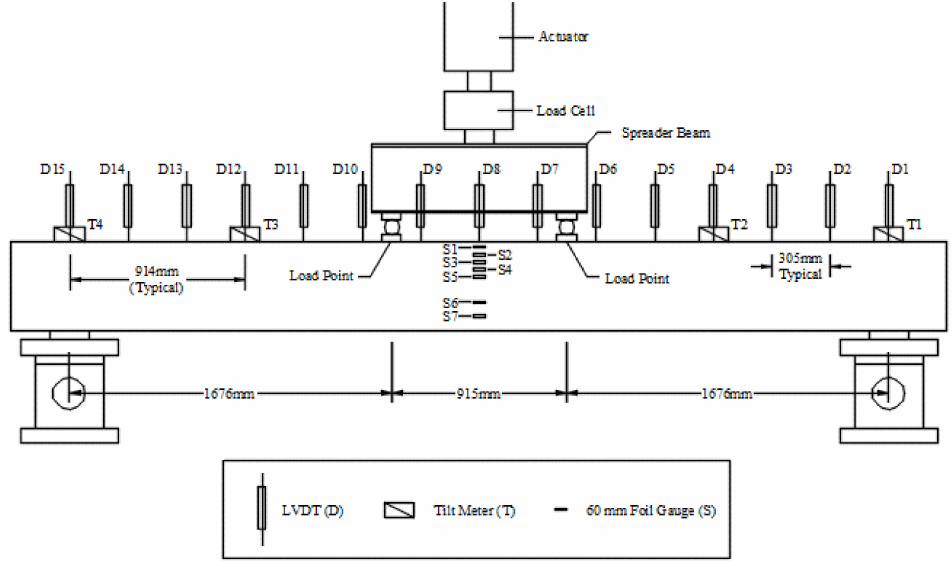
Figure 12. Schematic of the test set-up showing location of instruments used to measure load, displacement, and strains, as well as location of loading points with respect to supports.